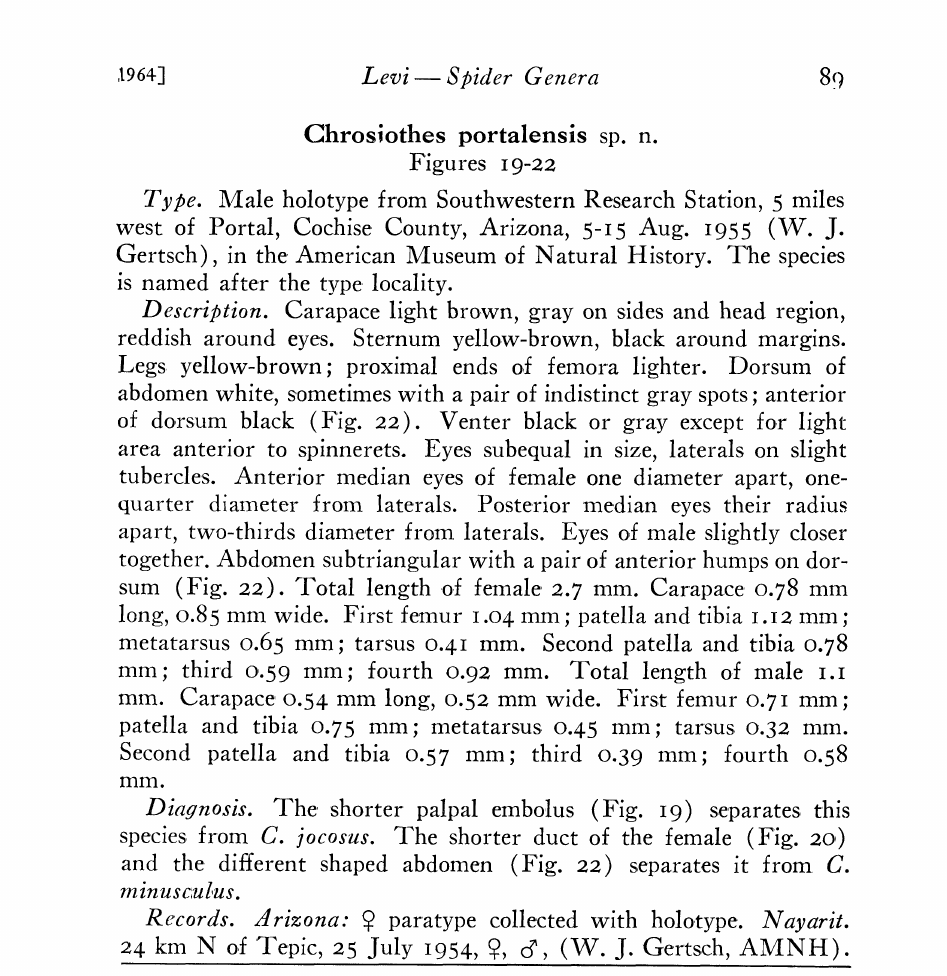
Fig. 25. C. silcaticus Simon, epigynum. Figs. 27-30. C. jarnaicensis sp. n. 27. Palpus. 28. Female genitalia, dorsal